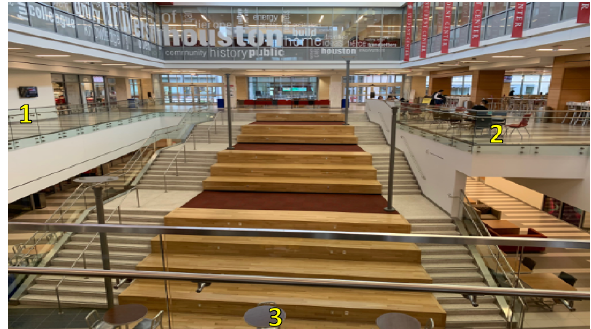
Figure 4. Photo of Data Collection Area in University of Houston Student Center. Yellow numbers indicate scanner set-up locations